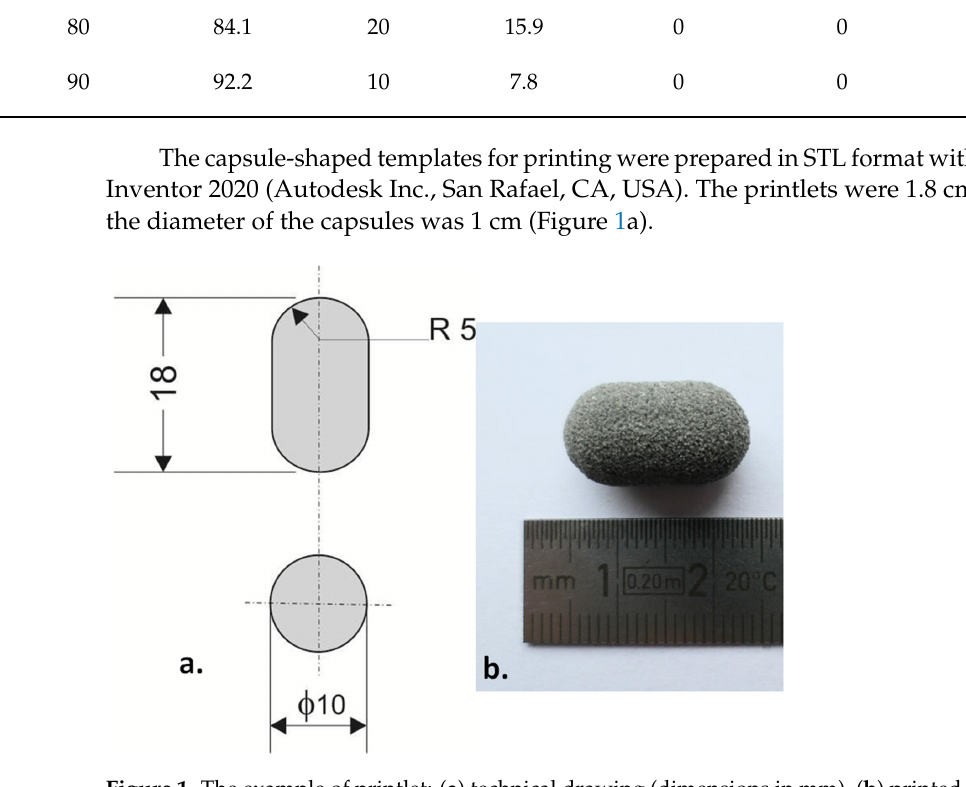
Figure 1. The example of printlet: ( a ) technical drawing (dimensions in mm), ( b ) printed Formulation A (80/20/0/100). A SLS was performed using Sintratec Kit 3D (Sintratec AG, Brugg, Switzerland) 3D printer equipped with a blue laser (2.3 W, 445 nm wavelength), operating under Sintratec Central software (v. 1.2.5, Sintratec AG, Brugg, Switzerland). The initial printing param- eters were tuned experimentally, and the following temperature targets were applied: powder surface temperature 115 °C and chamber temperature 100 °C. The thickness of a powder layer was 150 μ m, and the distance between two consecutive laser scans in the layer (hatch spacing) was 250 μ m for all formulations. Laser speed was in the range of 75–150 mm/s depending on the particular formulation, according to Table 1. Nine printlets per print job were manufactured. 2.2. Scanning Electron Microscopy (SEM) The powder microstructure and surface of printed samples were observed using a scanning electron microscope JSM-6610LV (JEOL GmbH, Tokyo, Japan). The tests were conducted using a low vacuum with a backscattered electron-composition image (BEC). The accelerating voltage was 15 kV. The chemical analysis was performed with energy dispersion spectroscopy (EDS) using the X-Max detector, equipped with Aztec v.2.1 software (Oxford Instruments, Oxford, UK). 2.3. Differential Scanning Calorimetry (DSC) Differential scanning calorimetry measurements were performed using the DSC822e cell with IntraCooler and STARe software v.8.10 (Mettler-Toledo, Columbus, OH, USA). Samples were weighed as received without preparation. About 10 mg of a studied sam- ple was weighed into the standard aluminum crucible (40 μ L). The crucible was hermet- ically sealed, and a lid was perforated before measurement. The samples were heated from 25 °C to 200 °C at 10 °C/min under a nitrogen atmosphere with 60 mL/min flow. The following temperature program was also used: (1) heating from 25 °C to 200 °C at 10 °C/min; (2) 5 min at 200 °C; (3) cooling from 200 °C to − 60 °C at 50 °C/min, heating from − 50 °C to 200 °C at 10 °C/min.